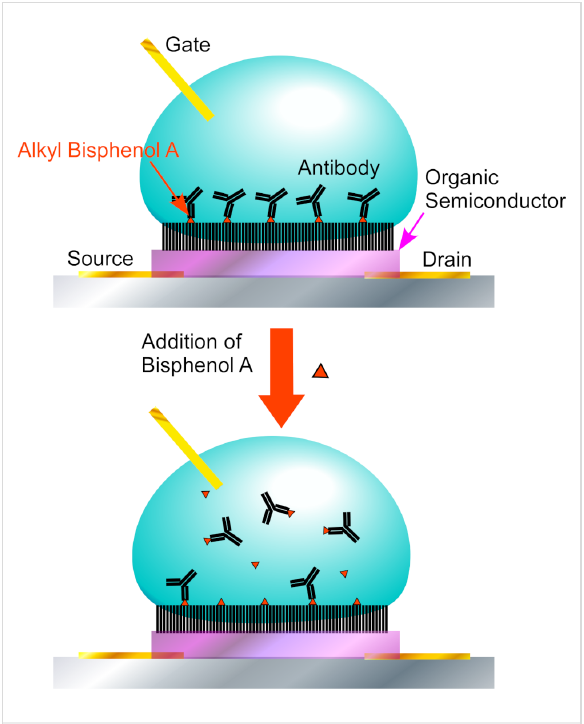
Figure 6: A field-effect transistor with a monolayer of pentathiophene- type organic semiconductor for melamine detection where the mono- layer structure of the semiconductive layer provides better sensor per- formance with long-term stability and high sensitivity.